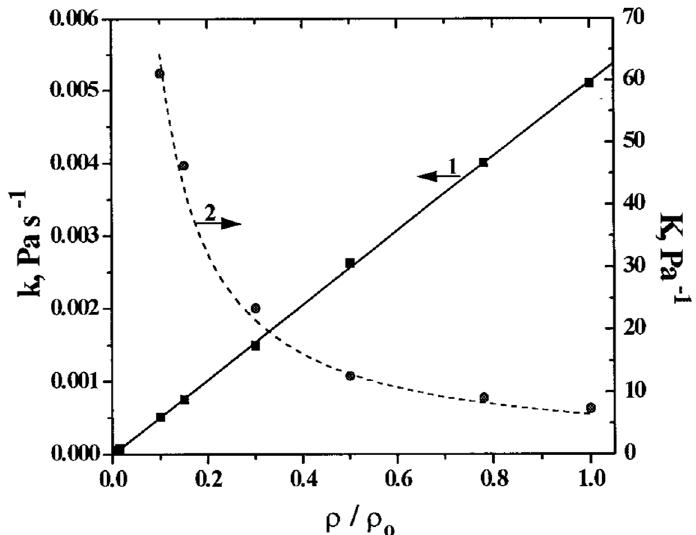
Figure 6. Dependence of the apparent constants k and K L on light intensity for the photostimulated adsorption of oxygen on ZrO 2 . Reproduced with permission from Emeline et al. [31]; Copyright 1998 by the American Chemical Society.